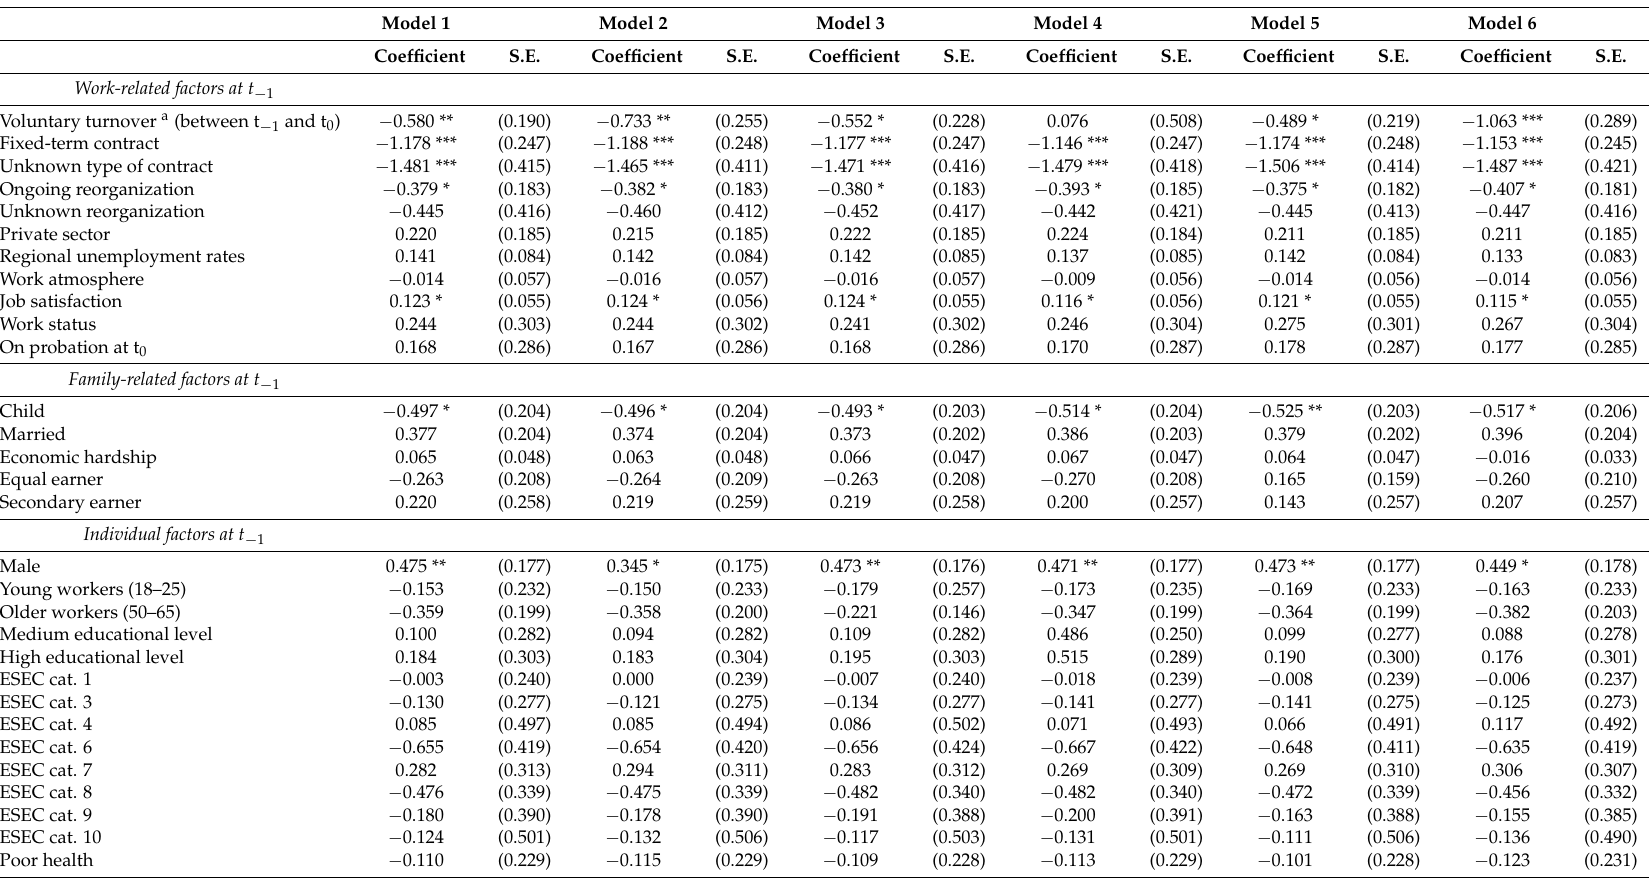
Table 3. OLS regression predicting changes in perceived job insecurity (negative values indicating a decrease); weighted sample matched on propensity